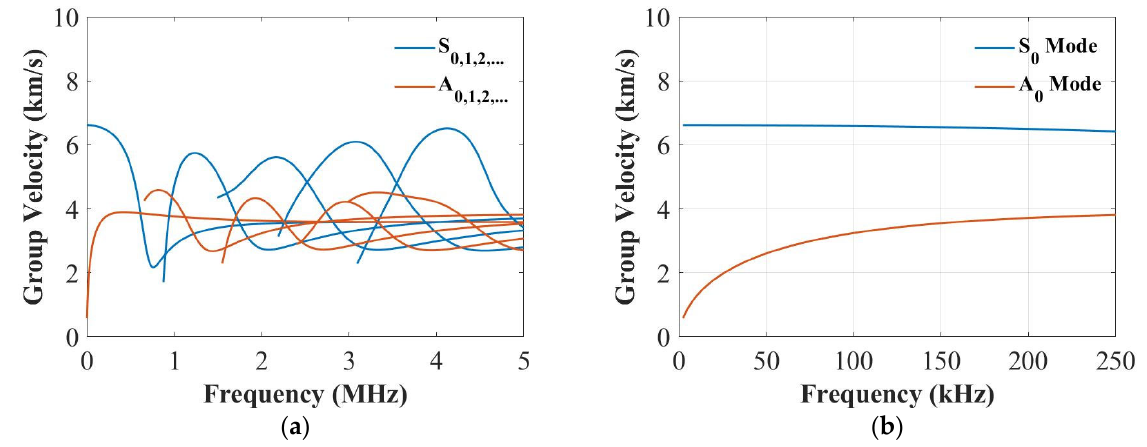
Figure 3. Dispersion curves for the group velocity from 0 to 5 MHz ( a ) and from 0 to 250 kHz ( b ) for the 4 mm thick panel.